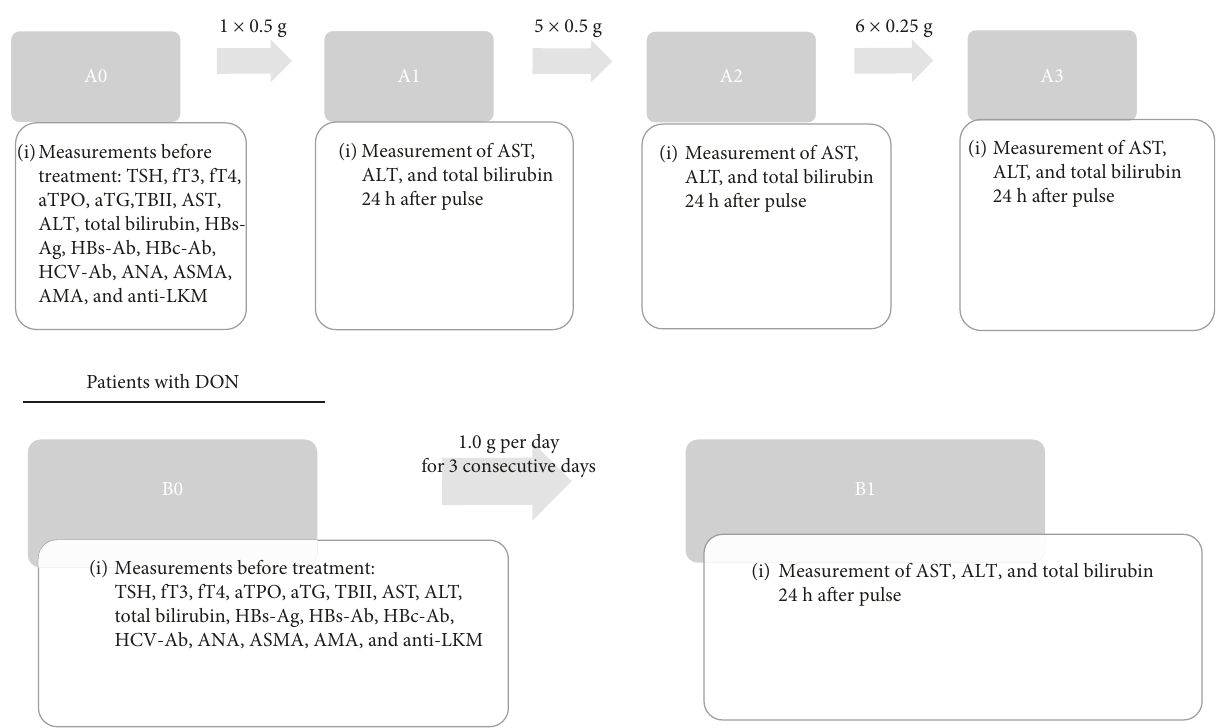
Figure 1: Treatment scheme. A0 — patients with moderate-to-severe GO before treatment; A1 — after administration of 0.5g intravenous methylprednisolone (IVMP); A2 — after administration of 3.0g IVMP; A3 — after administration of 4.5g IVMP; B0 — patients with